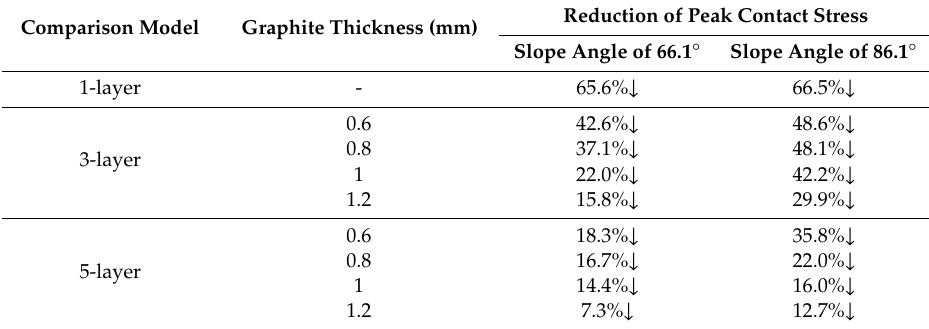
Table 7. Comparison of peak contact stress at the new seal with those at the 1-layer, 3-layer, and 5-layer models (350 ◦